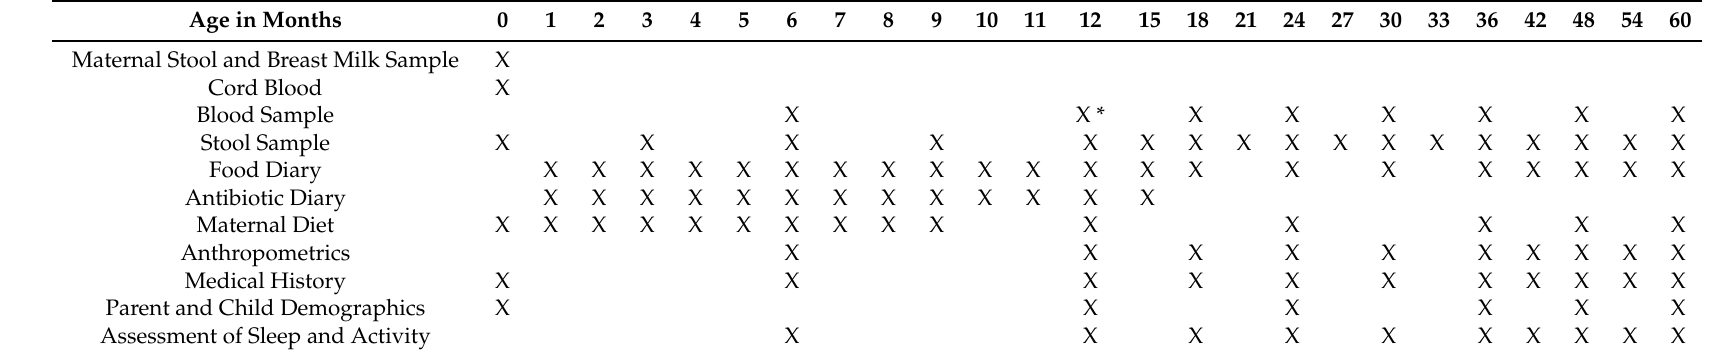
Table 1. Detailed schedule of data and samples collected throughout the CDGEMM